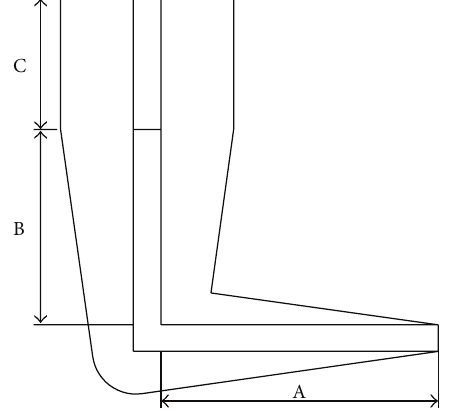
Figure 16: Basic shape of the transportation system with